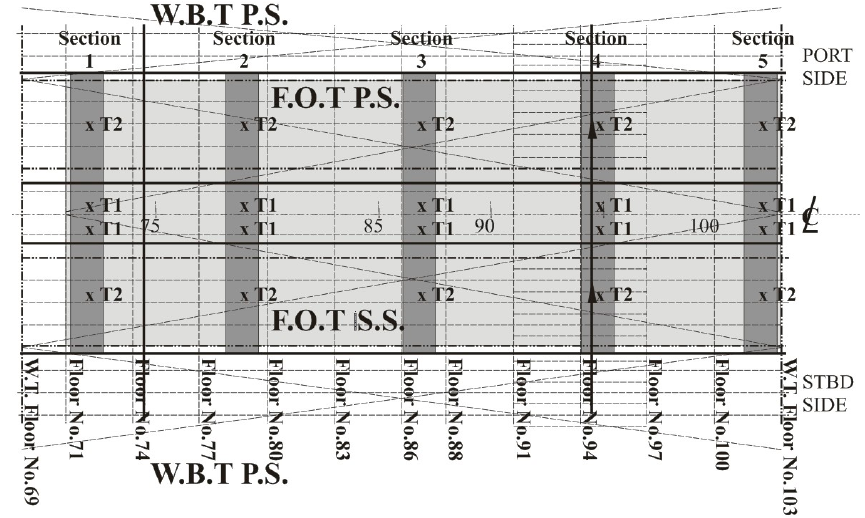
Figure 1. Collecting data scheme for inner bottom plates in the way of fuel oil tanks.